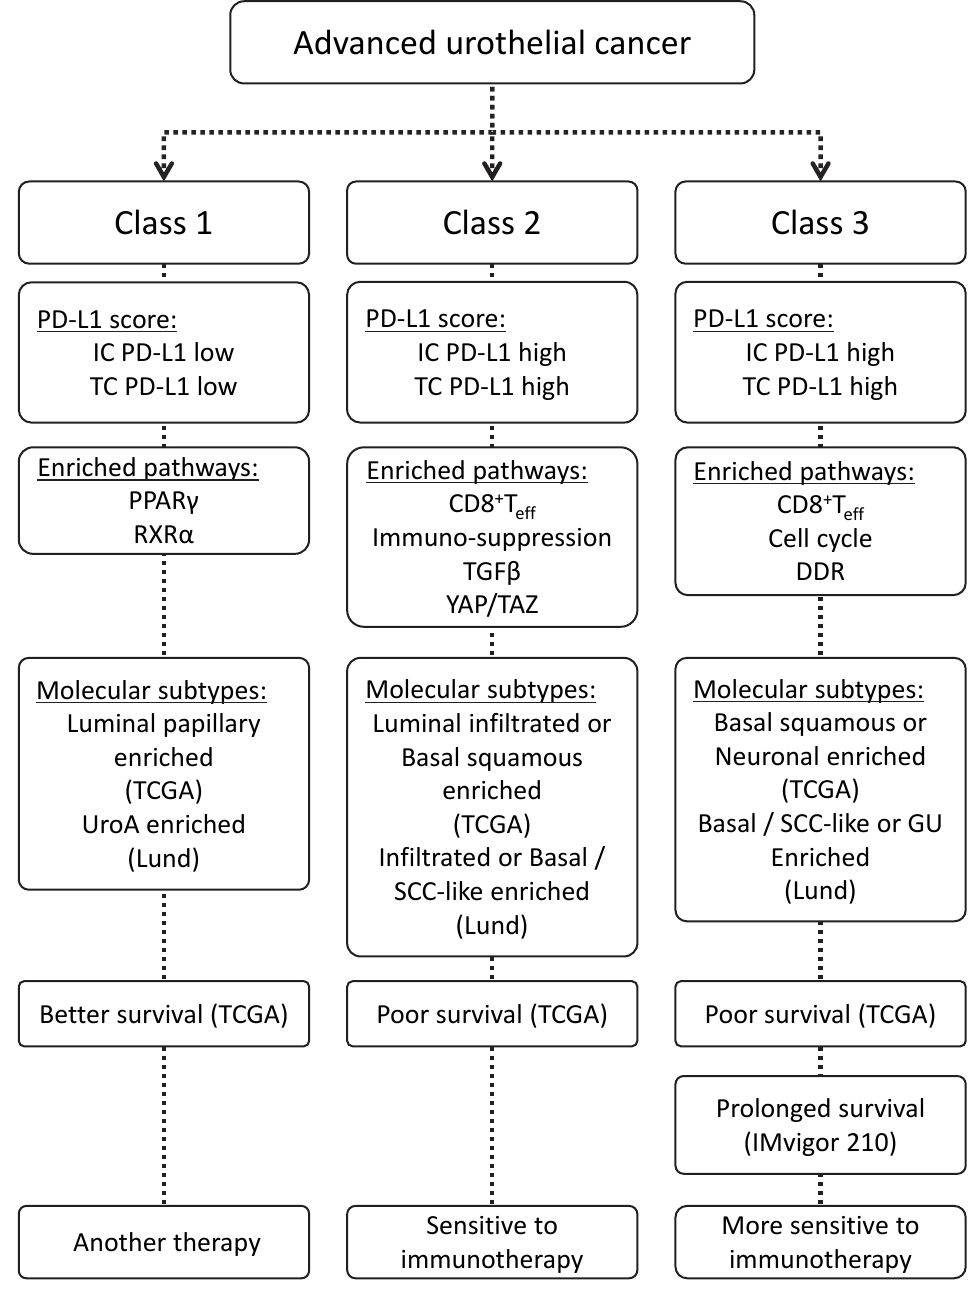
Figure 3. Schematic diagram of the characteristics of advanced urothelial cancer. T e ff , T e ff ector; DDR, DNA replication and DNA damage response; IC PD-L1, PD-L1 expression on immune cells; TC PD-L1, PD-L1 expression on tumor cell; SCC, squamous cell carcinoma; GU, genomically